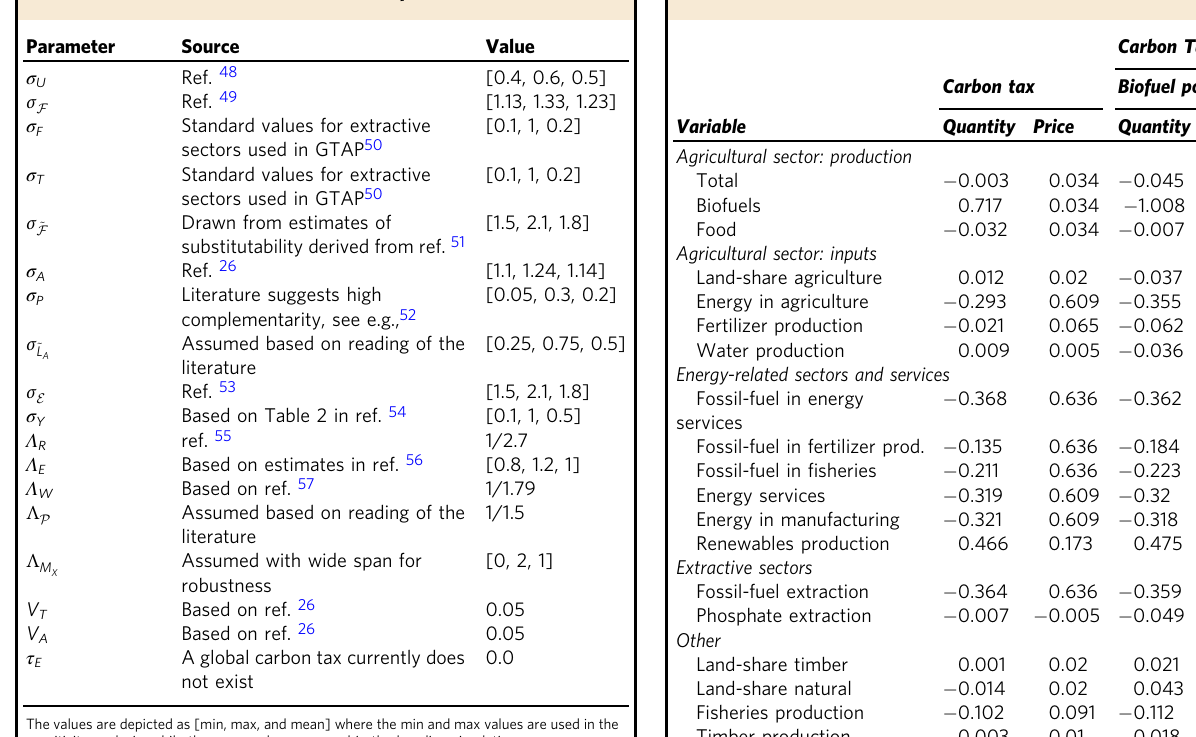
Table 4 Parameters — elasticities and quantities. Table 5 Baseline